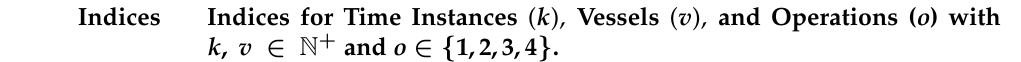
Table 2. Parameters and Variables used in the extended Mixed-Integer Linear